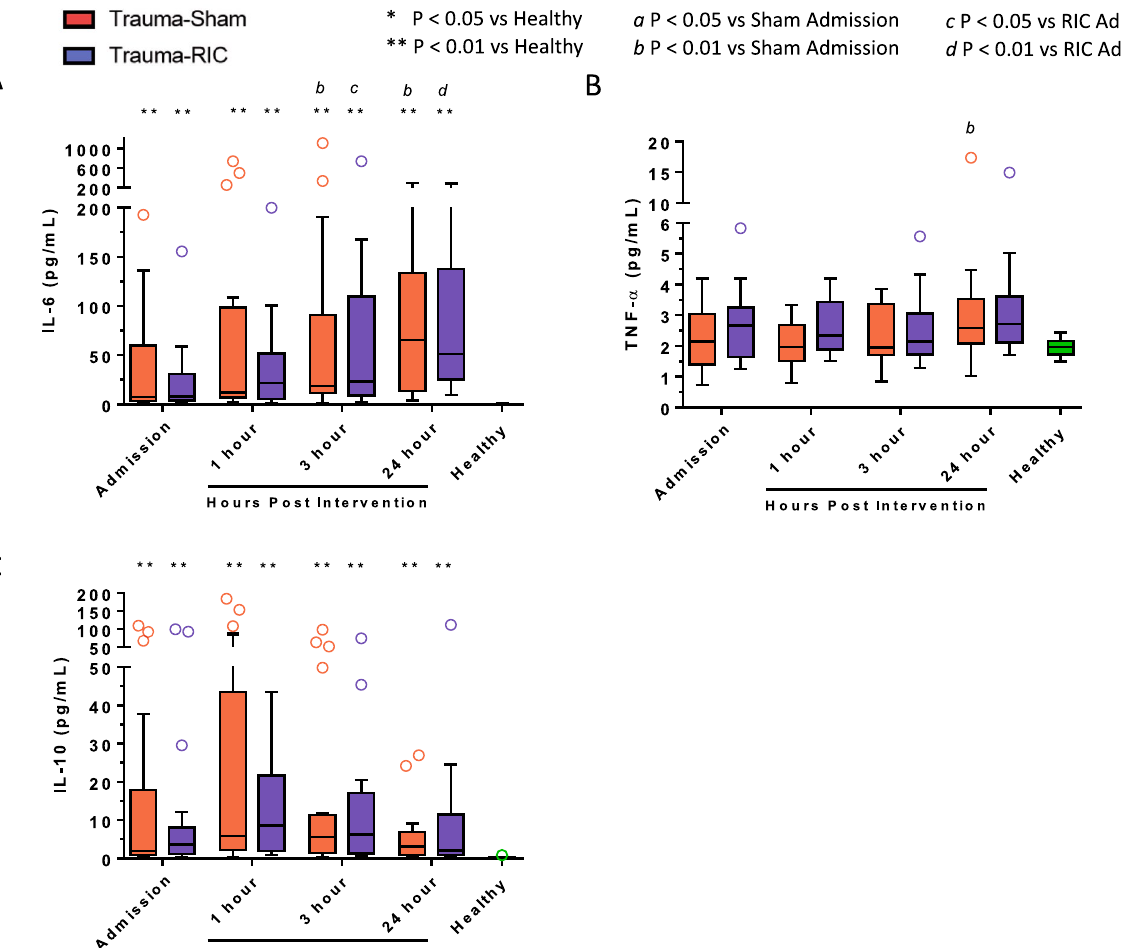
Figure 4. Plasma cytokine levels in trauma patients. ( A ) IL-6, ( B ) TNF-α, ( C ) IL-10. Red open circle = Trauma- Sham. Blue open circle = Trauma-RIC. Green open circle = Healthy Controls. Lines represent the median and interquartile range. a P < 0.05 vs Sham Admission. b P < 0.01 vs Sham Admission. c P < 0.05 vs RIC Admission. d P < 0.01 vs RIC Admission. *P < 0.05 vs Healthy Controls. **P < 0.01 vs Healthy